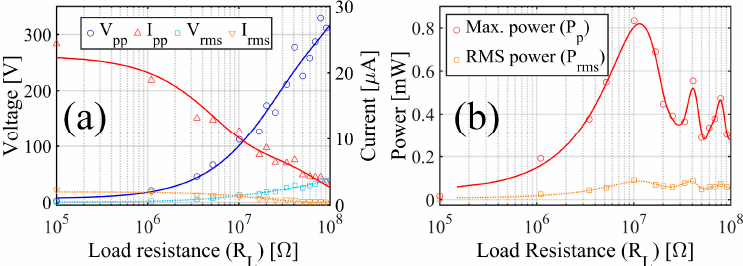
Figure 3. Electrical response of stretchable TrEG with respect to (cid:1844) (cid:3013) ( a ) output voltage and current; and ( b ) corresponding power output for tapping motion.